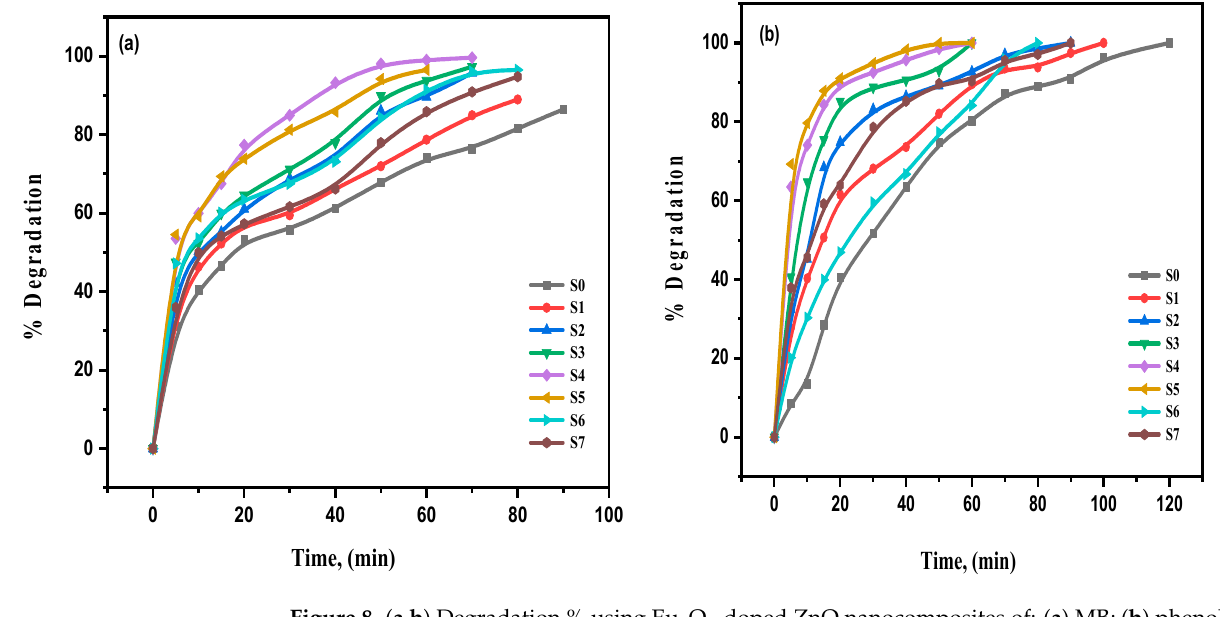
Figure 8. ( a , b ) Degradation % using Eu 2 O 3 -doped ZnO nanocomposites of: ( a ) MB; ( b ) phenol.